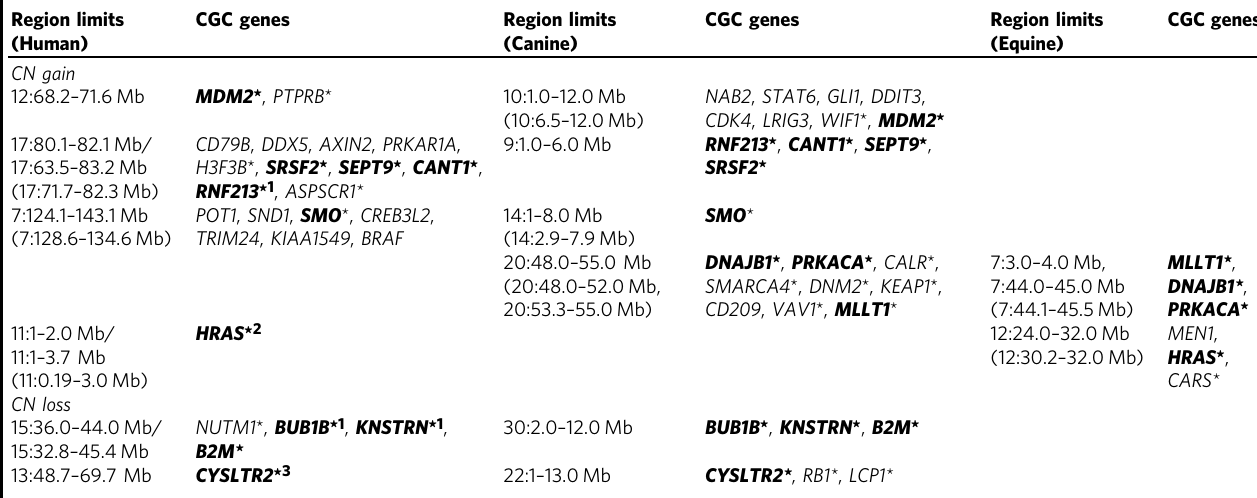
Table 1 Cross-species comparison of candidate genes in regions of signi fi cant copy number gain or loss Region limits